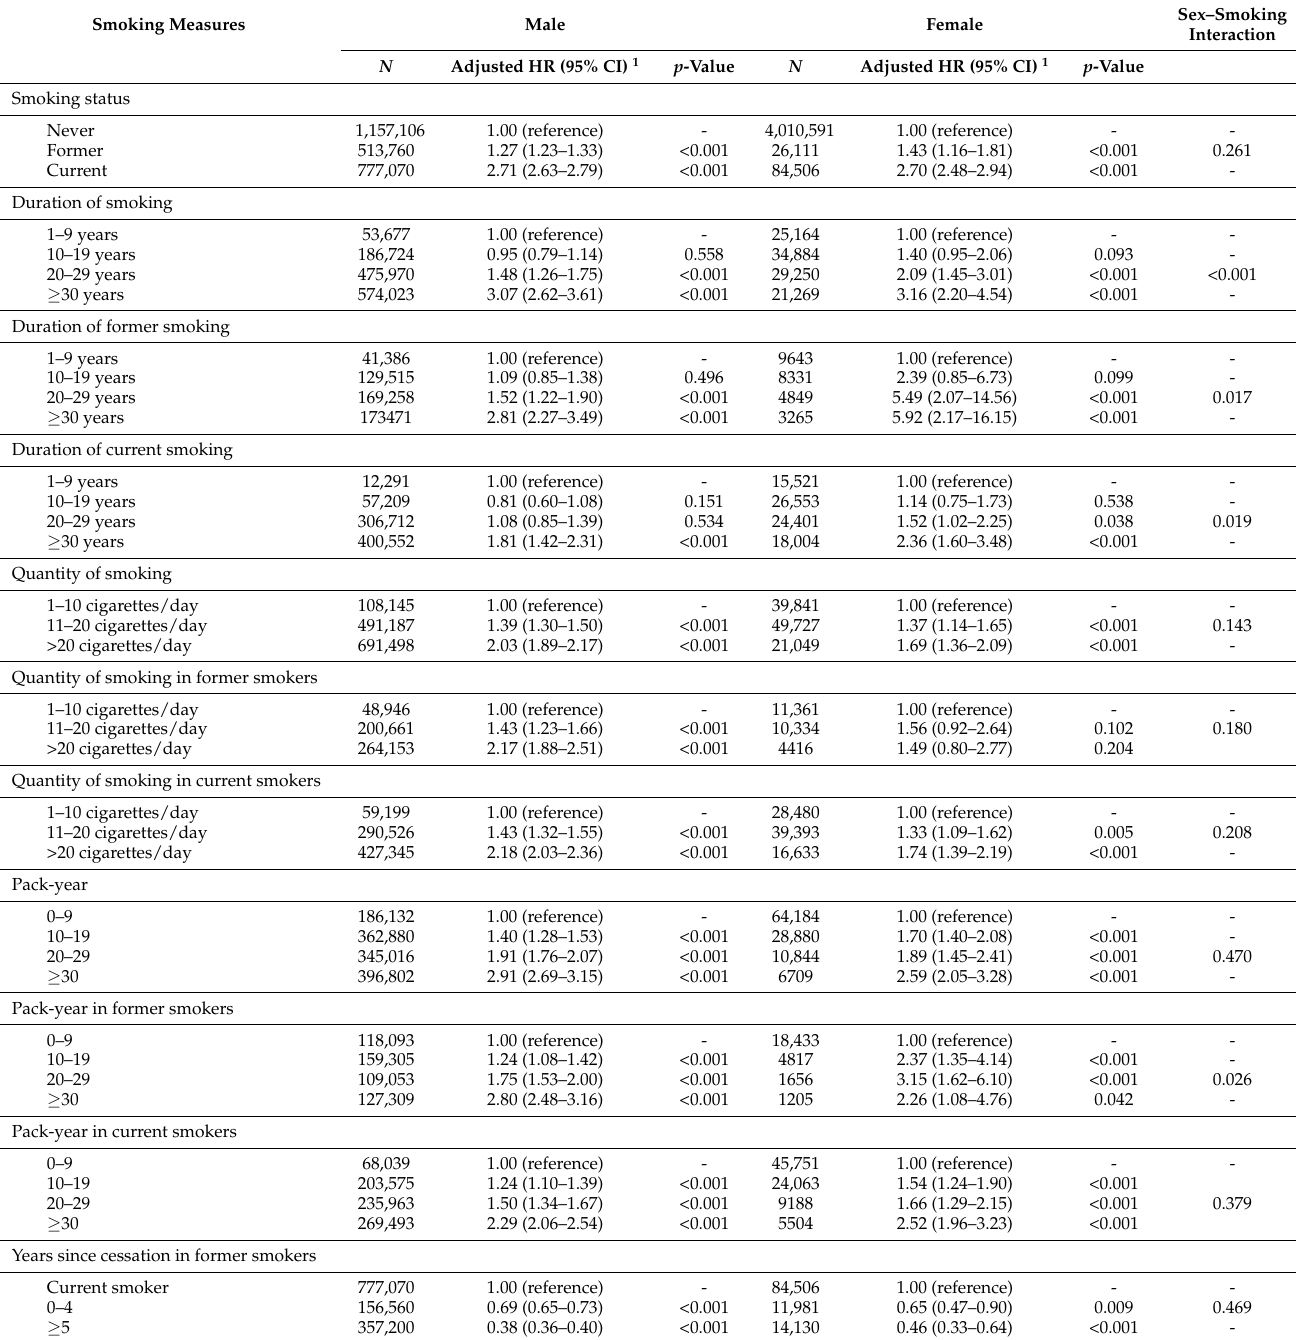
between sex and smoking status on lung cancer risk ( P -interaction: 0.261). Table 3. Adjusted risk of lung cancer according to the measures of various smoking